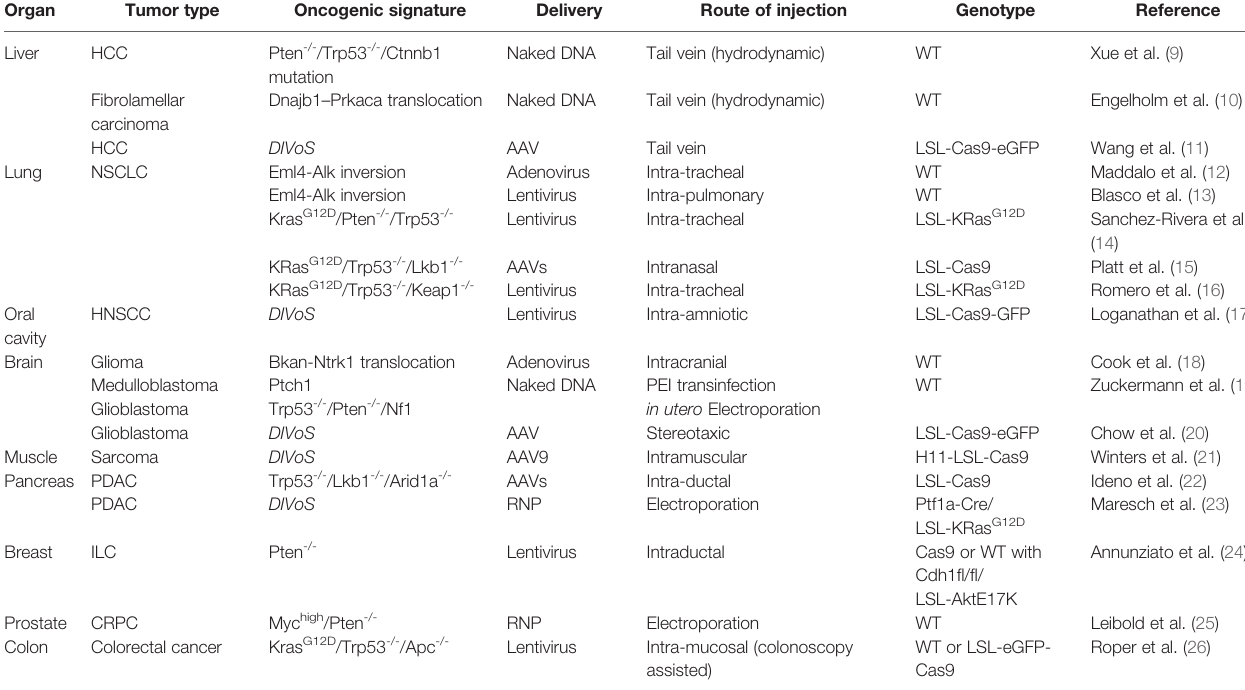
TABLE 2 | Summary of SEMMs and application as DIVoS.